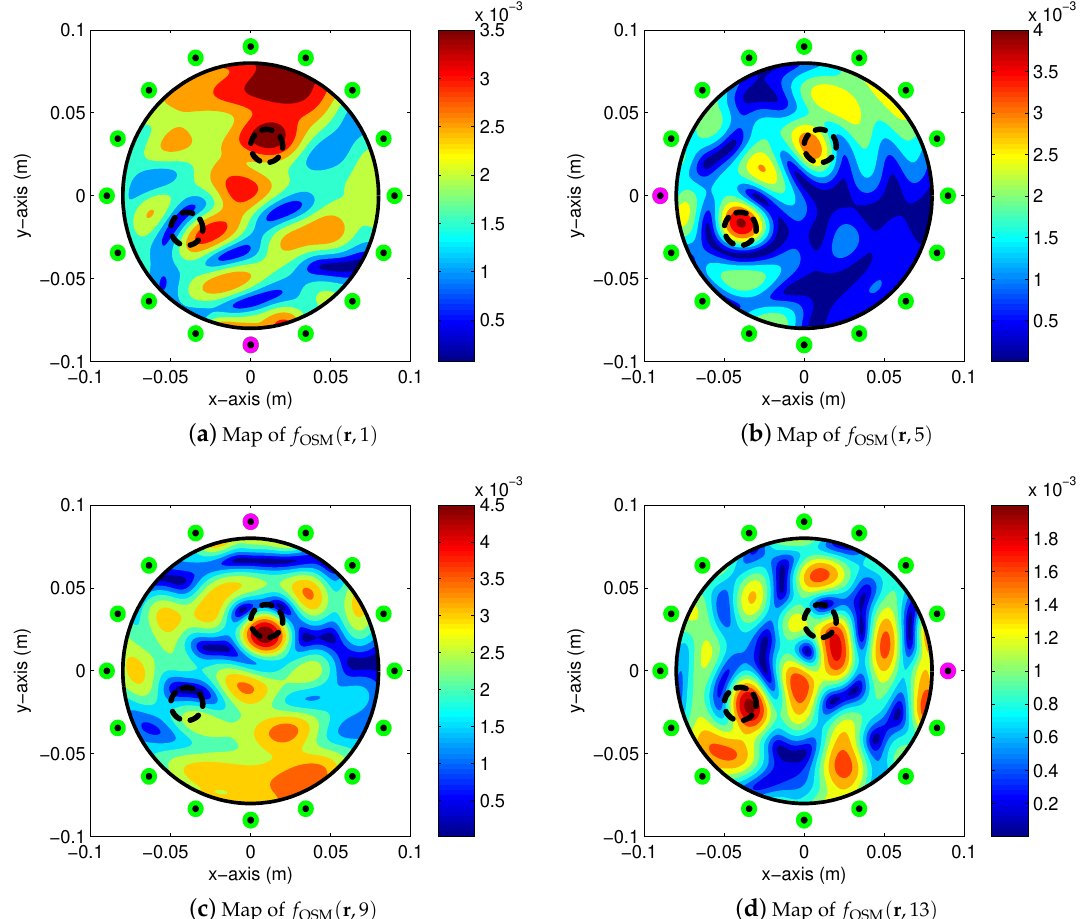
Figure 5. (Example 3) Maps of f OSM ( r , m ) . Black-colored dashed circles describe the boundary of anomalies.